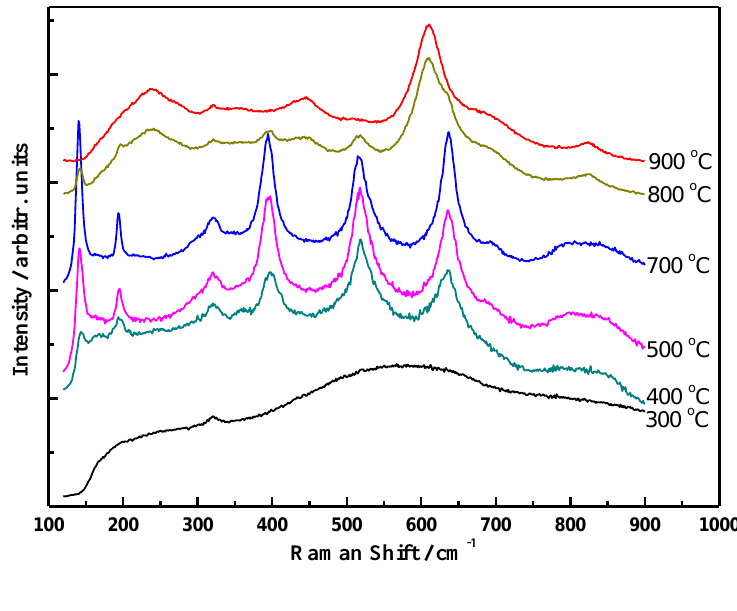
coatings annealed at different 2